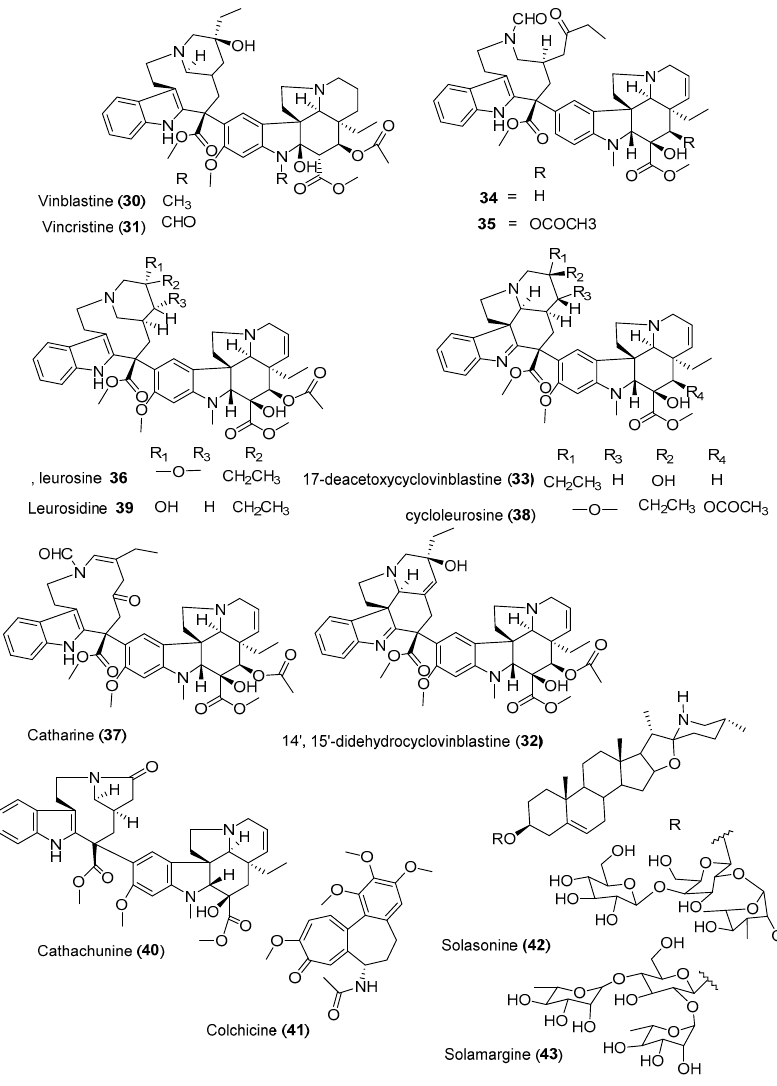
Figure 4. Structures of anticancer alkaloids reported from plants present in Ethiopia.